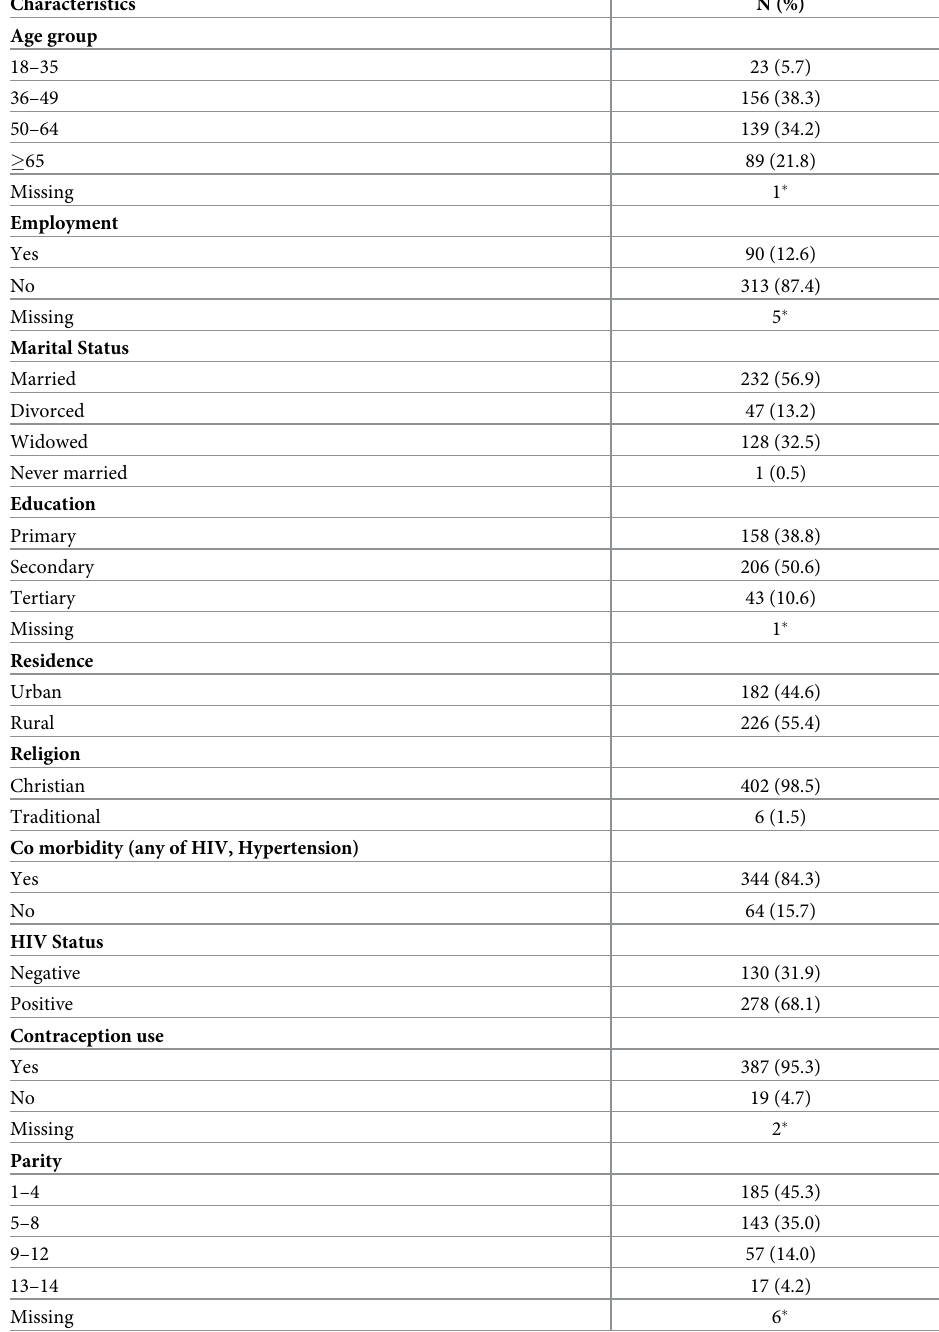
Table 1. Characteristics of the study population (N =